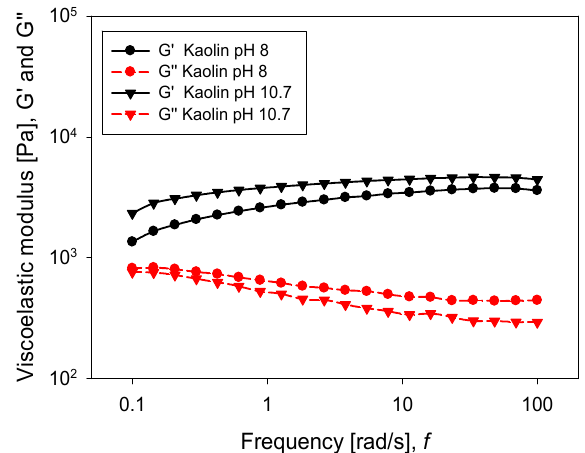
Figure 12. Frequency sweep for kaolin slurries at different pH levels.